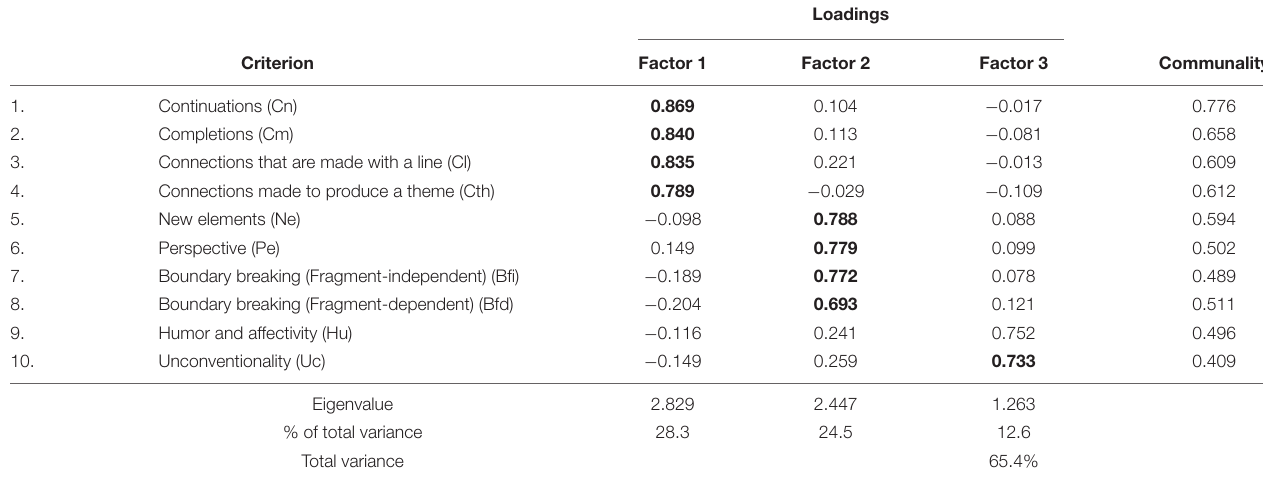
TABLE 3 | Rotated factor loadings, communalities, and results of EFA for the TCT–DP.